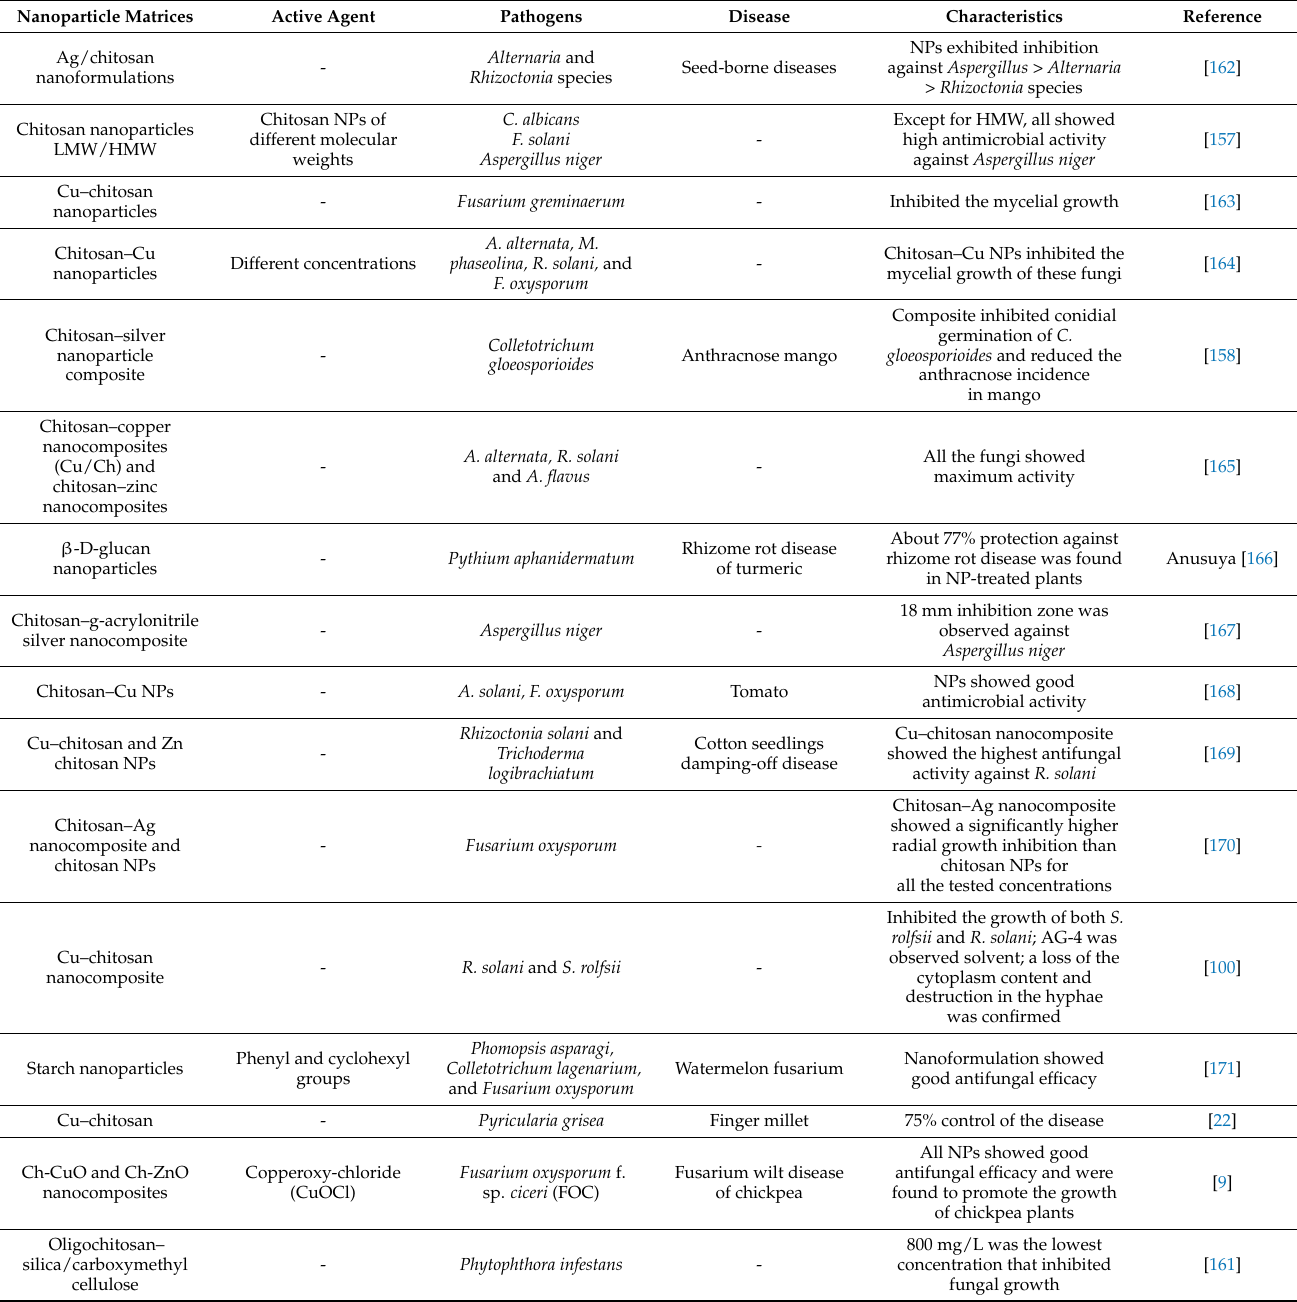
Table 8. Antimicrobial activity of some biopolymeric